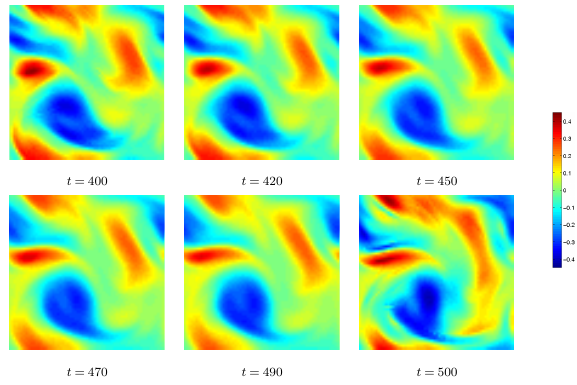
Figure 9. Standard particles smoothing result (see Sect. 2.2). Esti- Fig.9: Standardparticlessmoothingresult(seeSection2.2). Estimatedmeanvorticitymapsfordifferenttimes t betweenobservationtimes t =400 and t =500 . mated mean vorticity maps for different times t between observa- tion times t = 400 and t = 500. The result obtained with the proposed method is plotted on Figure 10. Estimated mean vorticity N M ( i ) (˜ ξ ( i )( j ) )˜ ξ ( i )( j ) maps are computed as t 500 i =1 w j =1 α P P